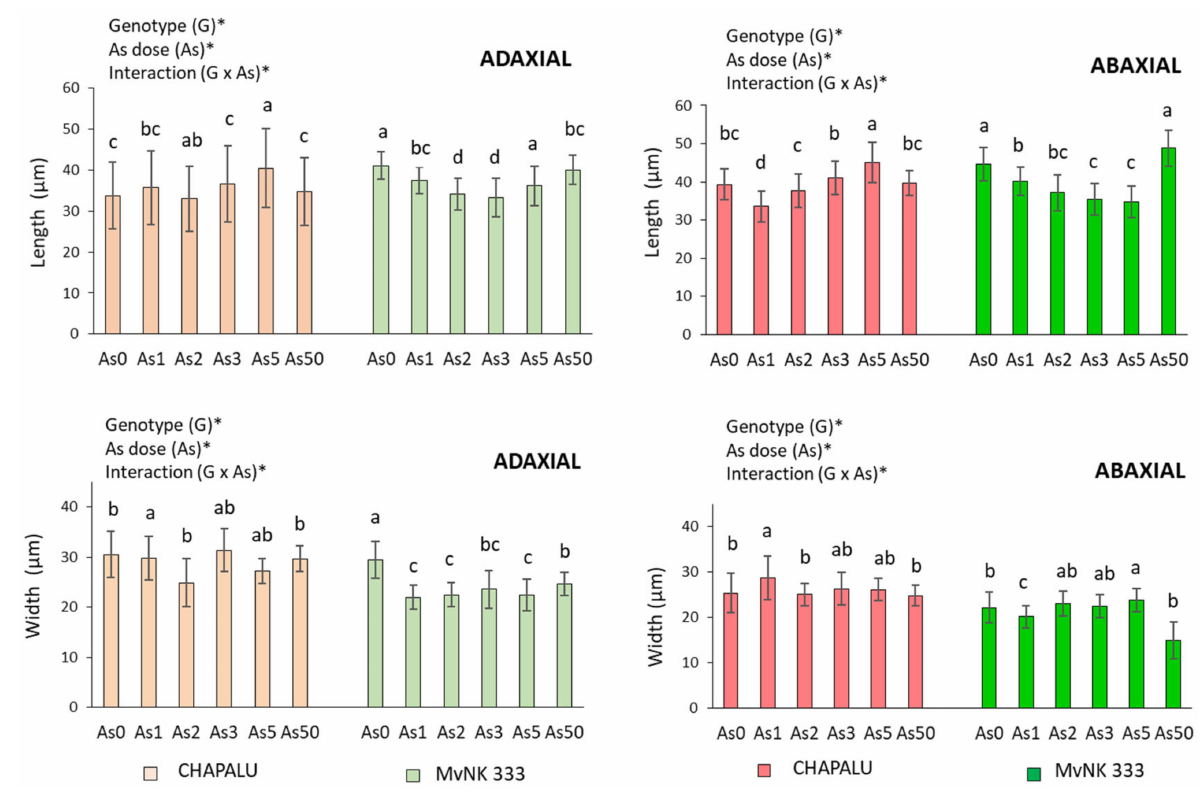
Figure 4. Effect of arsenic on size of stomata in adaxial and abaxial side of leaves of two cultivars of maize and their statistical evaluation. Data are presented as means ± SD from three biological replicates (n = 45). As0, As1, As2, As3, As5 and As50–arsenic addition to soil in mg kg − 1 . The differences between variants of the experiment were determined using the Kruskal–Wallis test followed by Dunn’s post hoc test for multiple comparisons. Different letters on the top of bars indicate a significant difference ( p < 0.05) between variants of the experiment for each cultivar. Data were also examined using two-way ANOVA with the factors As dose (As), genotype (G), and interaction (G x As). *—significance at 0.05